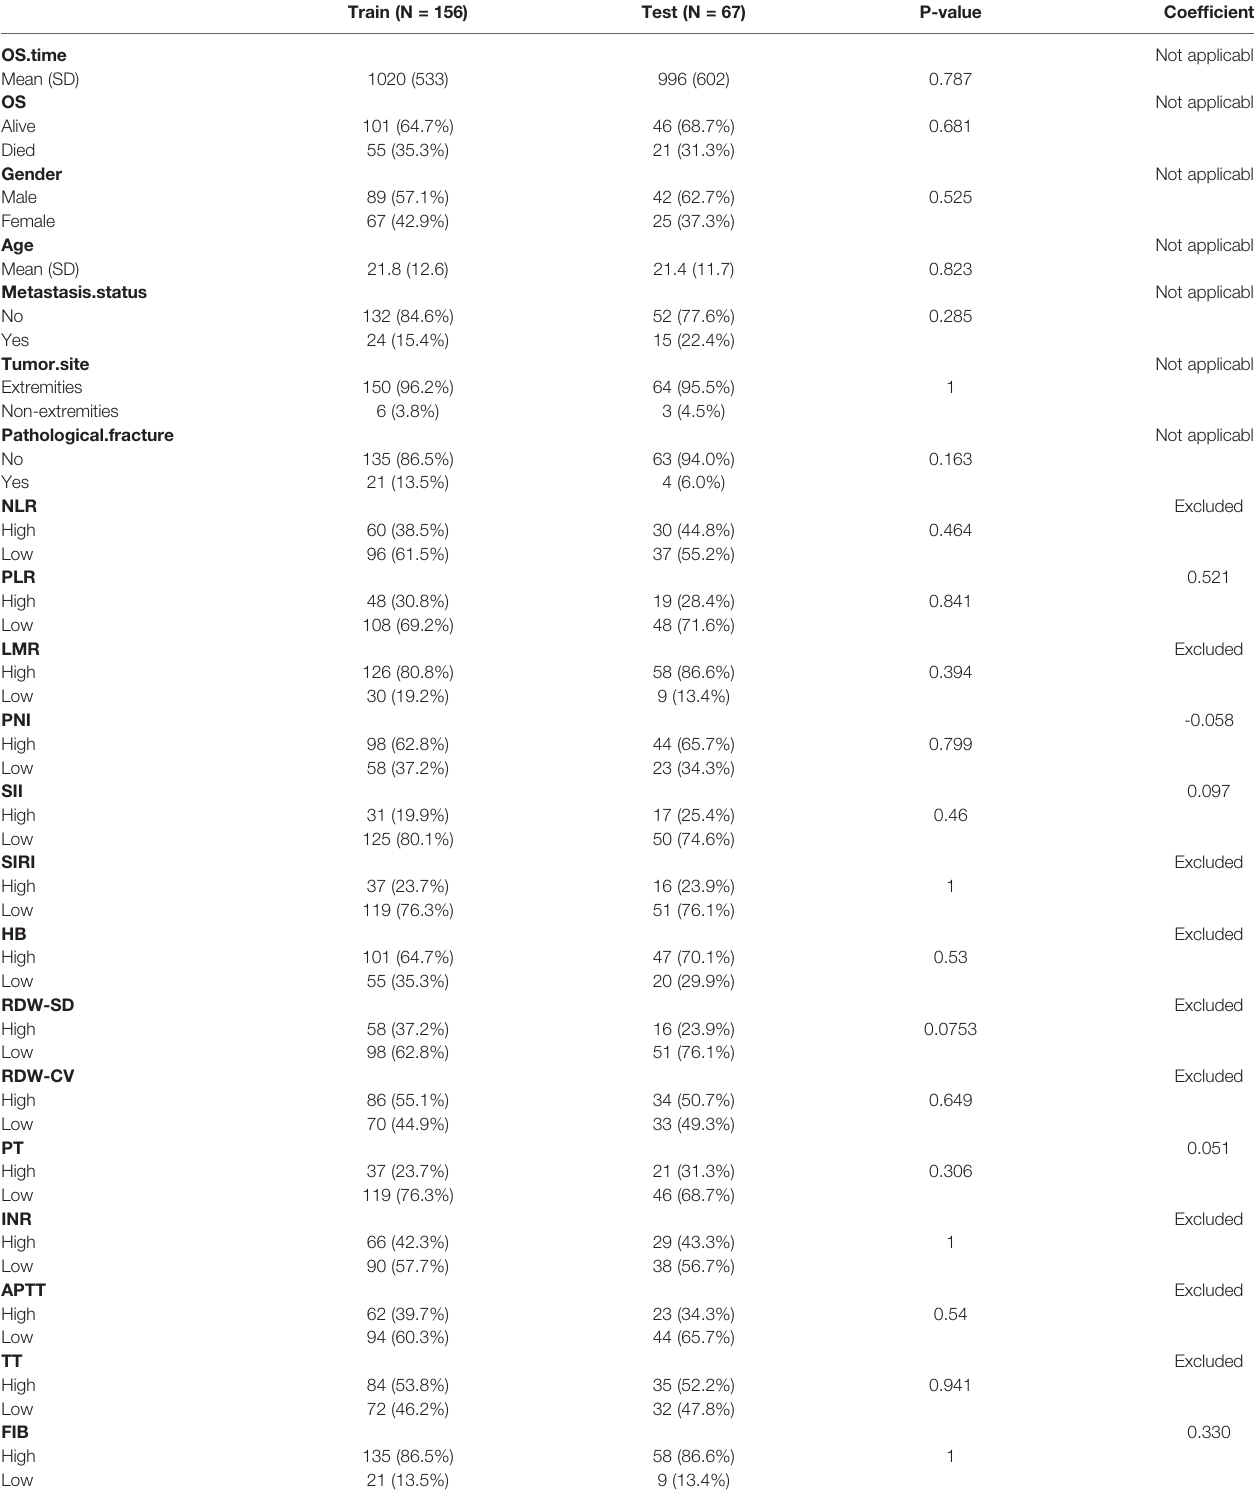
TABLE 1 | Differences in the distribution of all variables between the training set and the validation set and the respective coef fi cients of the seven hematological indicators that make up the HPSS. Train (N = 156) Test (N = 67) P-value Coef fi cient